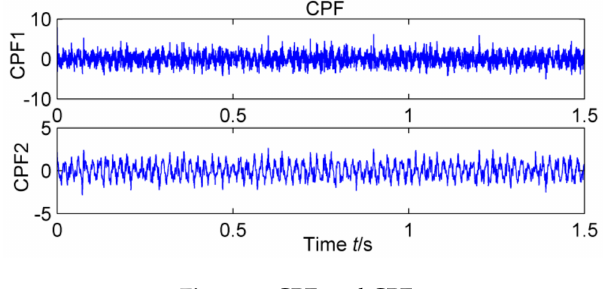
Figure 9. CPF 1 and CPF 2 .